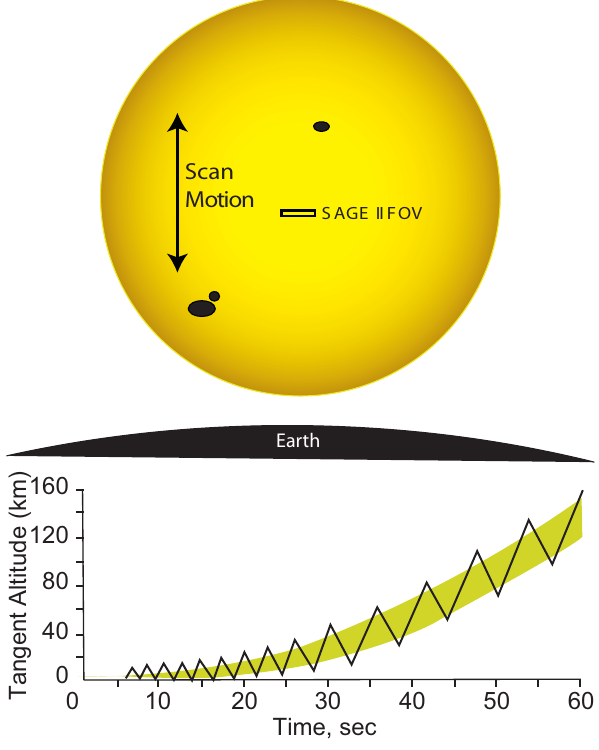
Fig. 1. A depiction of the SAGE II measurement geometry: SAGE II scans across the center solar disk perpendicular to the Earth’s surface (above). The figure below shows the pattern of scans for a sunrise event (the location of the Sun is shown in yellow), demon- strating that multiple rays between the instrument and the Sun pass at approximately the same minimum distance from the Earth’s sur- face (the tangent altitude).